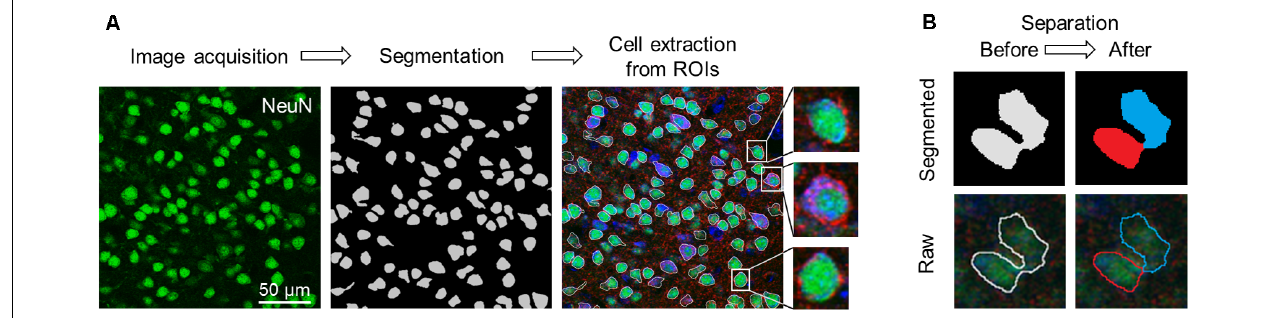
FIGURE 2 | Flowchart of image acquisition and preprocessing. (A) Workflow of cell extraction using the pre-trained segmentation network. (B) Diagram of the erosion-dilation algorithm. ROIs that enclosed multiple cells (left; pale gray) were separated into two or more parts (right; blue and red). Top: Segmented images. Bottom: Raw images. Abbreviation: ROI, region of